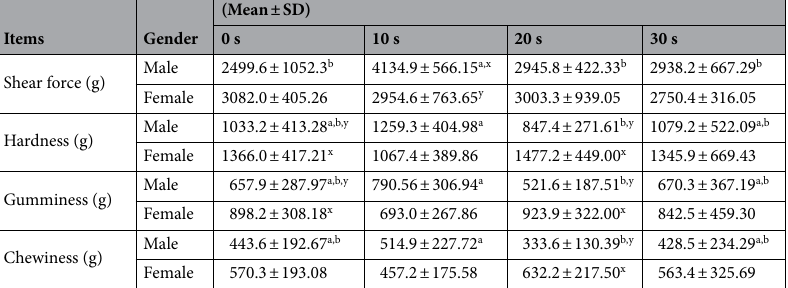
Table 7. Effects of cold plasma on shear force and TPA of boiled chicken breast. a,b,c , and x,y Values with different superscript letters in a column and row, respectively, are significantly different (p-value <